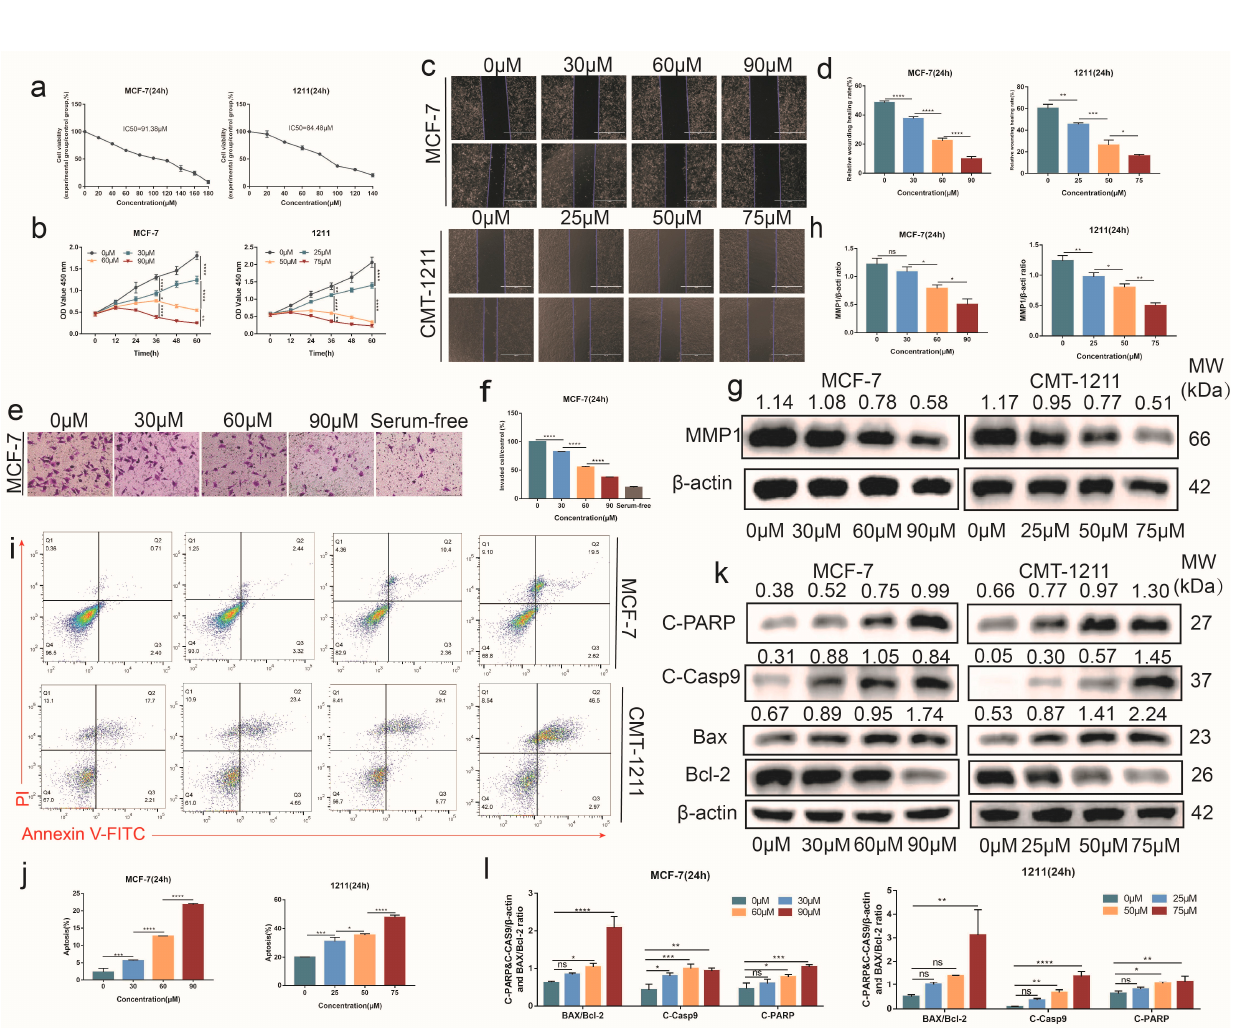
Figure 3. SNH inhibited the invasive and proliferative abilities of MCF-7 and CMT-1211 and promoted apoptosis. ( a ) Cell Counting Kit-8 kits were used to detect the activity of MCF-7 and CMT-1211 after treatment with different concentrations of SNH for 24 h. ( b ) Cell Counting Kit-8 kits were used to assess the cell activity of MCF-7 and CMT-1211 cells treated with different concentrations of SNH at 0, 12, 24, 36, 48, and 60 h. ( c , d ) Wound-healing assays were used to measure the cell migration capacity after SNH treatment for 24 h. Scale bar: 1000 µm. ( e , f ) Transwell chambers precoated with matrigel were used to examine the cell invasion ability of MCF-7 and CMT-1211 cells after SNH treatment for 24 h. Scale bar: 200 µm. ( g , h ) Western blot was used to detect the expression levels of MMP1 in MCF-7 and CMT-1211 cells treated with SNH for 24 h. ( i , j ) Flow cytometry was used to examine the effect of SNH on apoptosis. ( k , l ) Western blot was used to detect the expression levels of apoptosis-related proteins BAX, Bcl-2, cleaved caspase-9, and cleaved PARP in MCF-7 and CMT-1211 after being treated with SNH for 24 h. All results are expressed as mean ± SD of three independent experiments. * p < 0.05, ** p < 0.01, *** p < 0.001, **** p < 0.0001, ns = not significant.